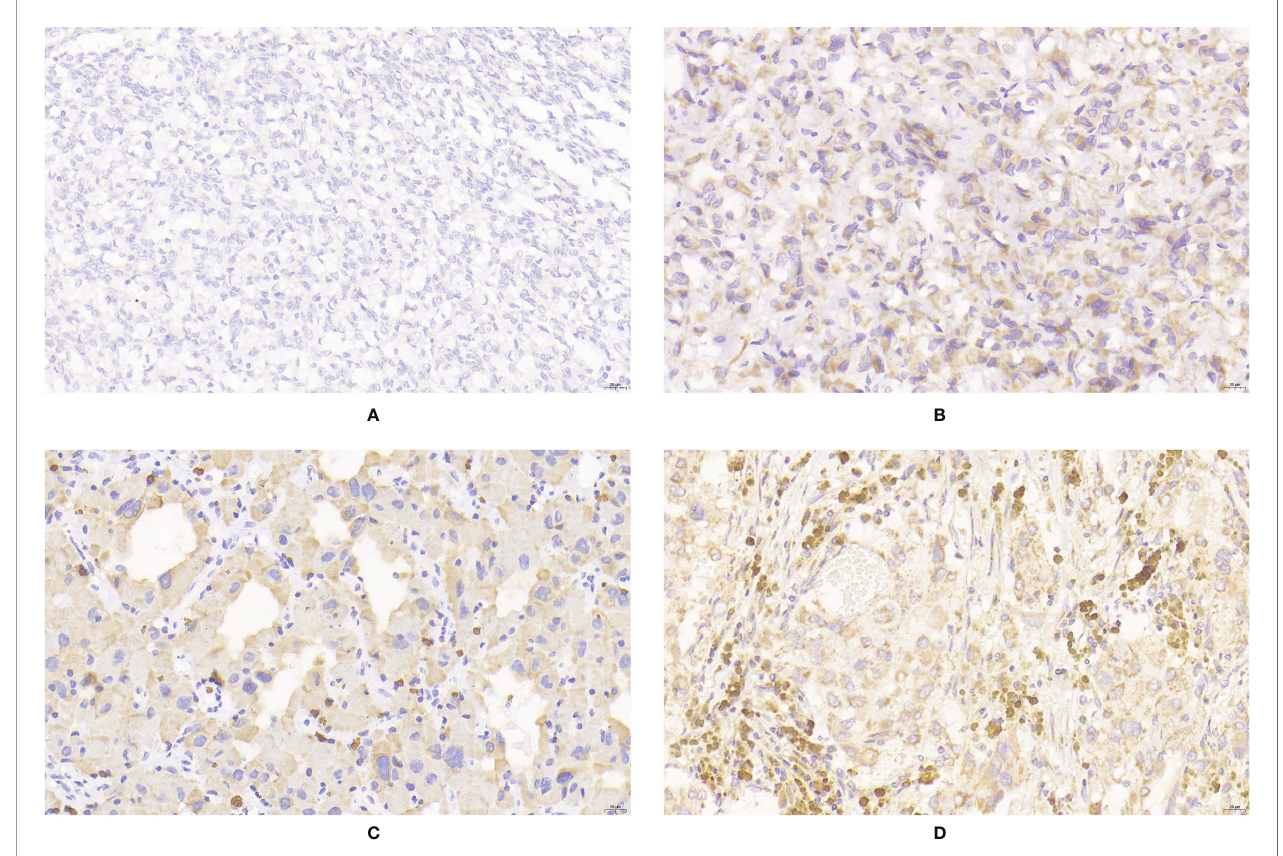
FIGURE 4 | Expression of SDHB in PPGLs. (A) Negative immunostaining of SDHB in PPGLs. (B) Weakly positive immunostaining of SDHB in PPGLs. (C) Intermediately positive immunostaining of SDHB in PPGLs. (D) Strongly positive immunostaining of SDHB in